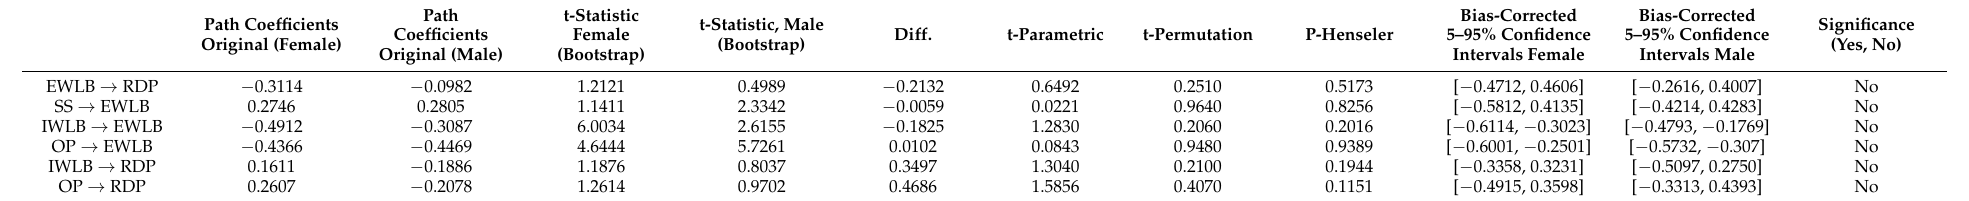
Table 11. Results of Multigroup Analysis